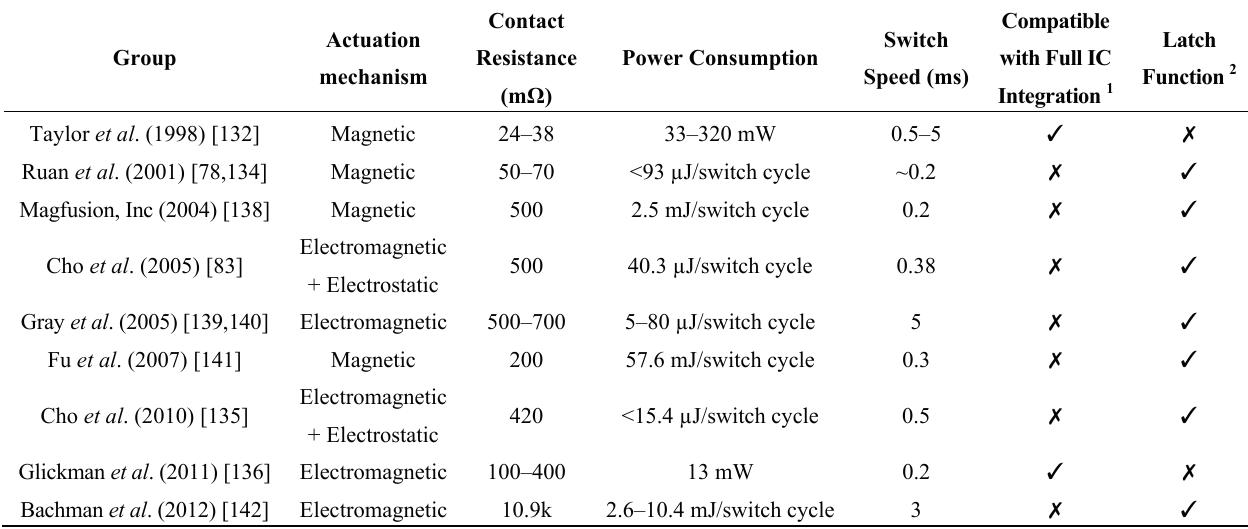
Table 3. Magnetic MEMS switches reported in the literature, in chronological